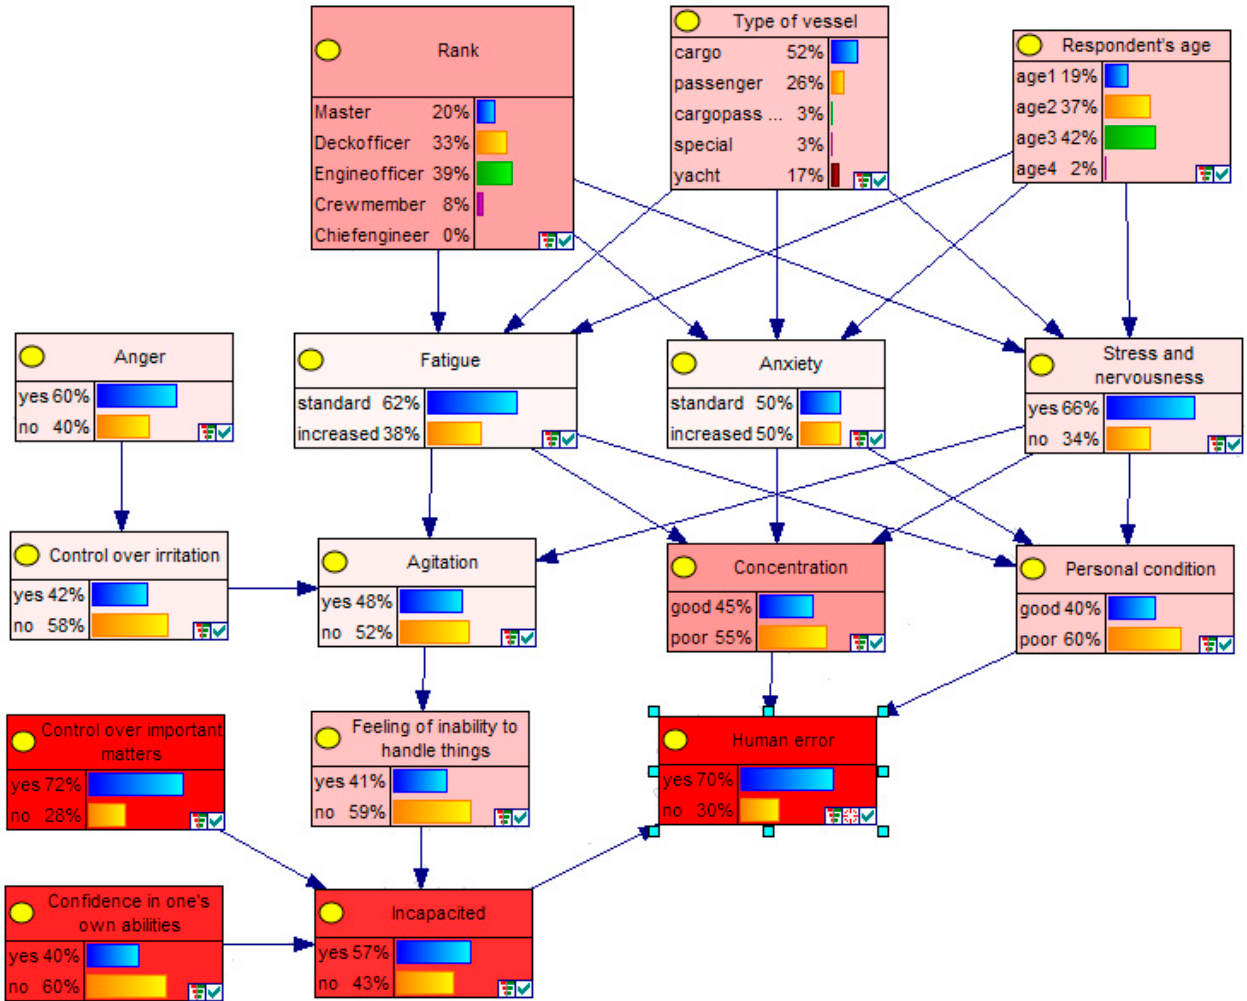
Figure 8. Presentation of sensitivity by targeting the variable Human error .